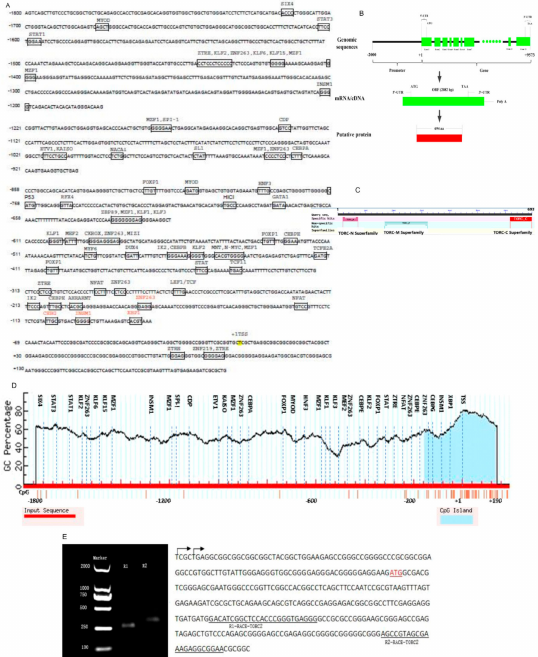
Figure 4. Structural characteristics of the bovine TORC2 gene. ( A ) The 5 (cid:48) UTR promoter region sequence of the TORC2 gene. The transcription start site has been highlighted with yellow color, transcription binding sites of the respective cis-acting elements in the promoter of TORC2 gene have been boxed with their respective names shown above the line, while selected transcription factors ( C / EBP γ , XBP1, ZNF263, and INSM1 ) were shown with a red color font in the core promoter region of TORC2 gene. ( B ) The molecular structure of the TORC2 gene with total length, number of exons, ORF, and number of amino acids. ( C ) The protein sequence has been shown with specific hits for domains site and super families in the protein sequence of the TORC2 gene. Three domains hits, including TORC-N, TORC-M and TORC-C, have been shown in the protein sequence with their specific hit sites. ( D ) The CpG island is indicated with the blue color. Horizontal dash line indicates the GC percentage in the promoter region of TORC 2 gene. The dash vertical lines show transcription factors binding sites with their respective names mentioned in the top. The horizontal red line indicates the input sequence of the TORC2 gene promoter. The transcription start site is marked with + 1. ( E ) Transcription start site of TORC2 gene through RACE (for 5 (cid:48) end). TORC2 5 (cid:48) RACE PCR product gel electrophoresis band (left). The sequence of TORC2 gene is (right), transcription start sites indicated with arrows, reverse primers sequence has been presented with underline sequence and translation start site (ATG) is shown with red